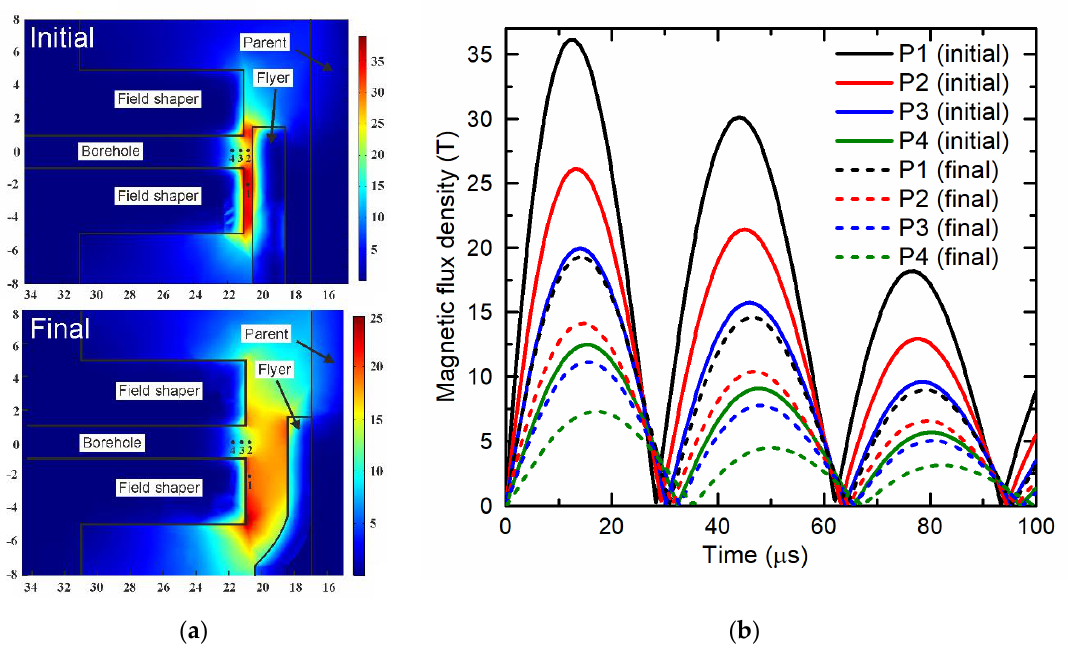
Figure 7. COMSOL simulation results of the magnetic field distribution at four positions in the gap between flyer and field shaper for the initial and final flyer deformation states (( a ) strength of the magnetic field, ( b ) magnetic field oscillation). P1 is unaffected by the borehole, P2 is at the same radial position in front of the borehole, P3 and P4 is 0.5 and 1 mm inside the borehole, which is approximately the position of the probe in the experiments.